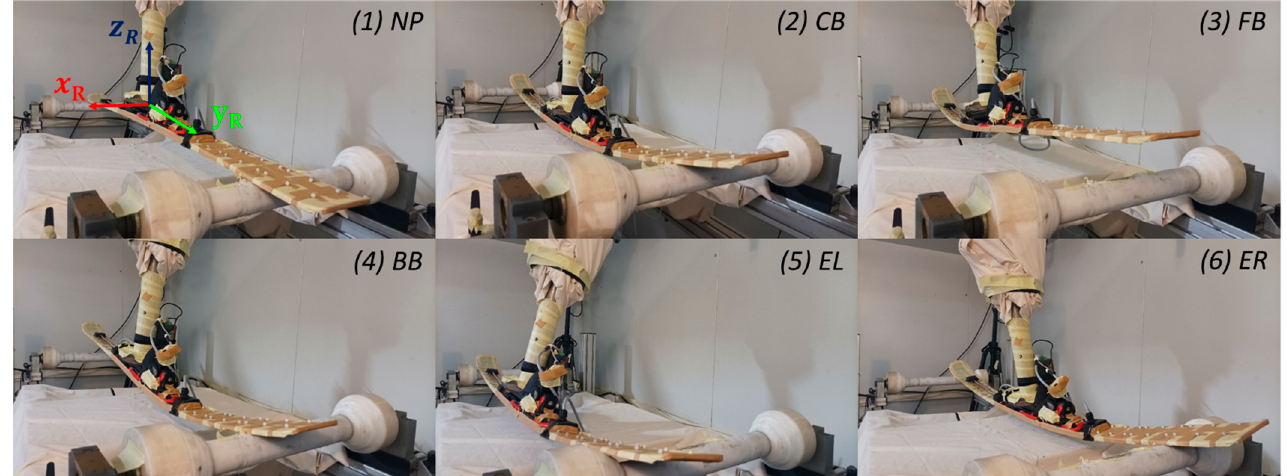
Figure 2. Experimental setup consisting of bending robot with the reference coordinate system (x R , y R , z R ) and the PyzoFlex ® ski prototype that was equipped with the instrumented 3D markers. Deformation sequence of the ski on the bending robot: NP: neutral position; CB: central bending; FB: front bending; BB: back bending; EL: edging left; ER: edging